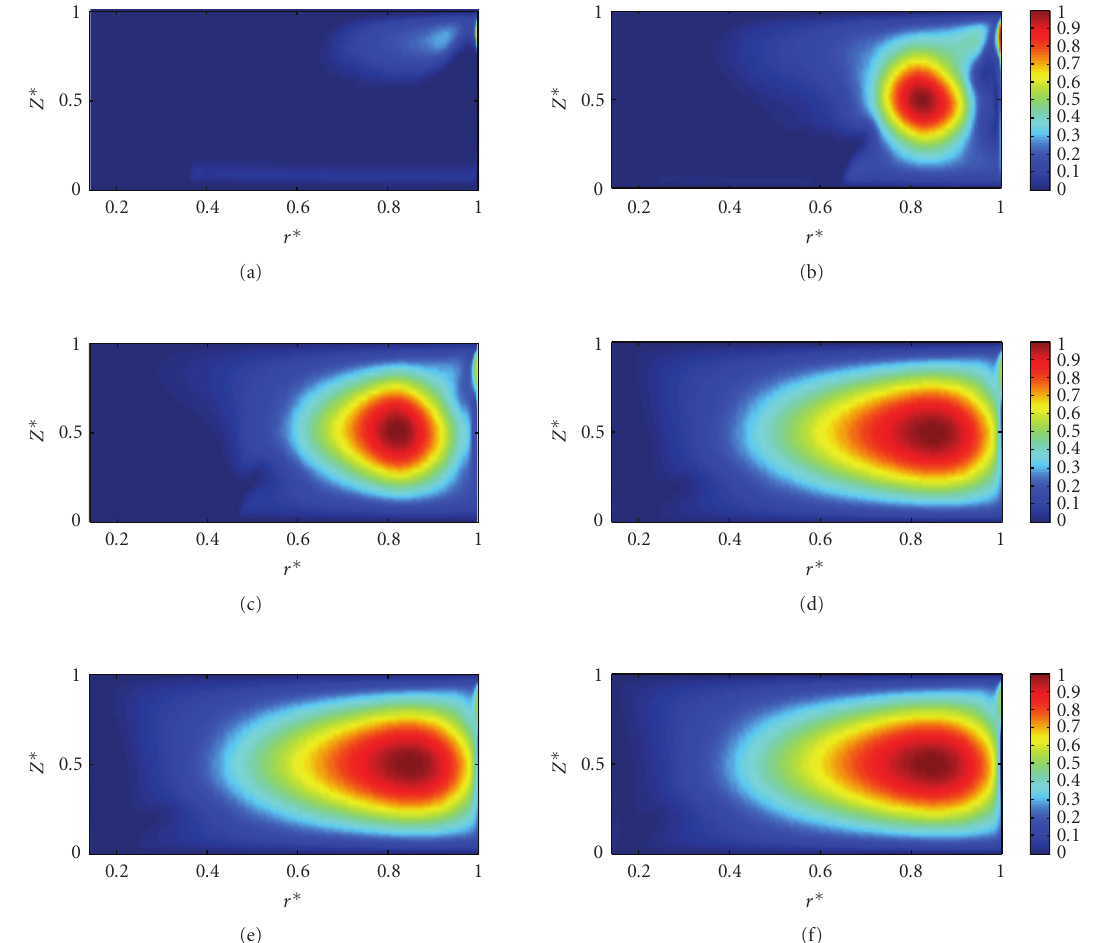
= 57 . 61; (b) 5 × 10 5 , Re max = 4128 . 3. t max